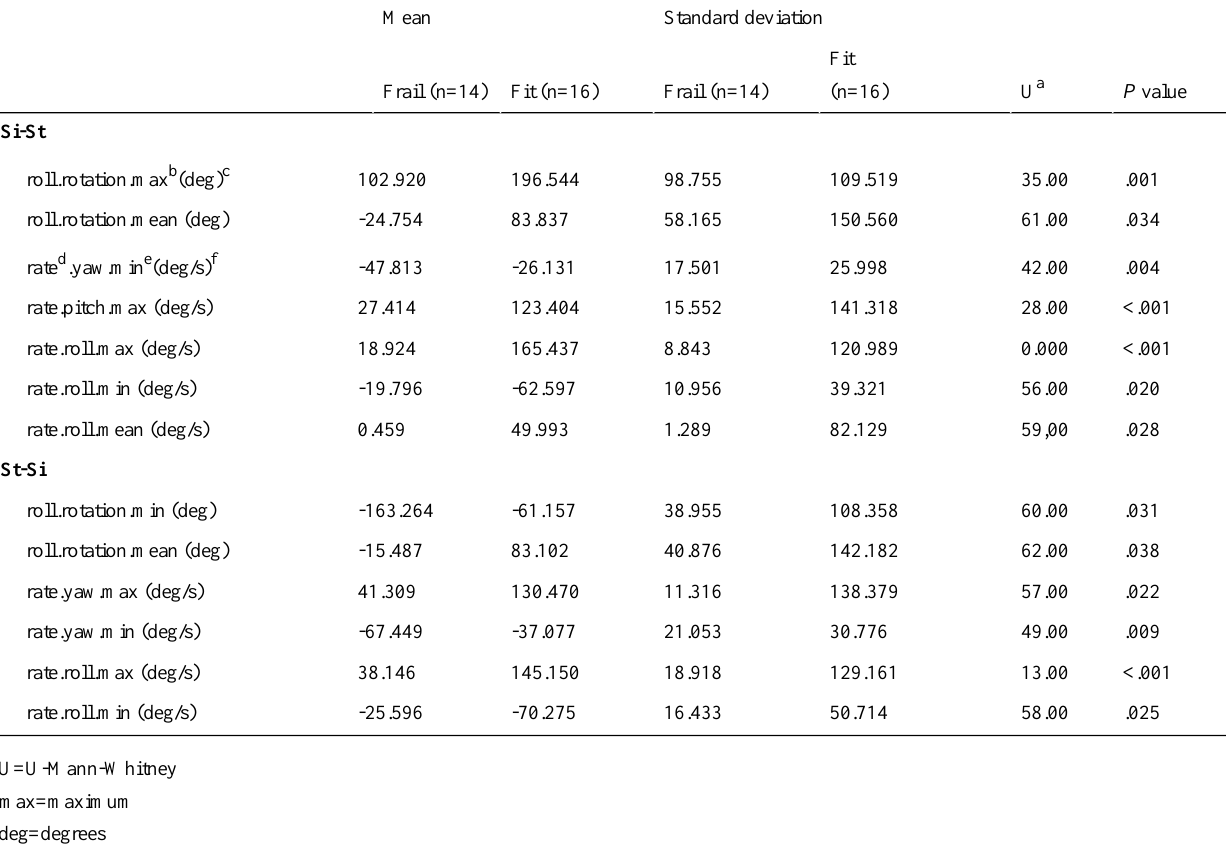
Table 3. Gyroscope-based values from the Si-St and St-Si transitions (N=30).